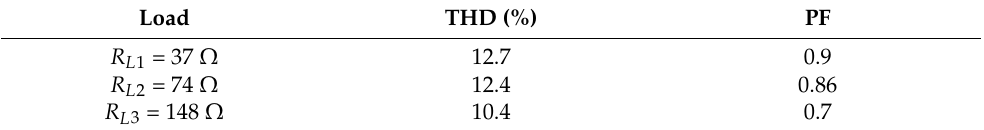
Table 16. CTU total harmonic distortion and power factor under unbalanced input voltage